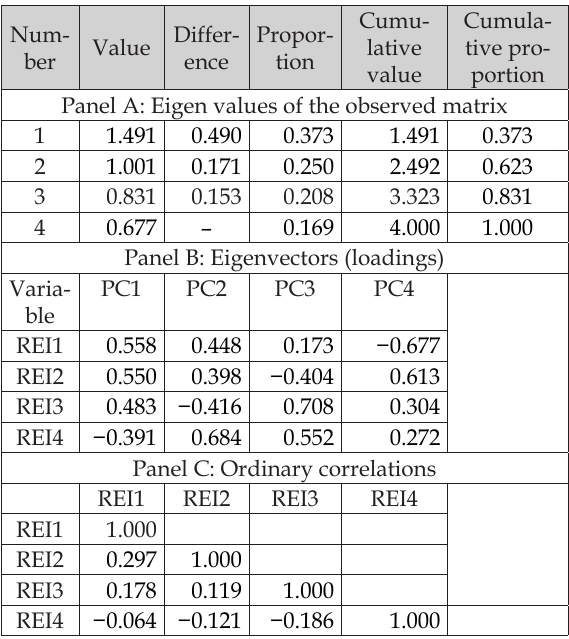
Table 11. Principal component analysis